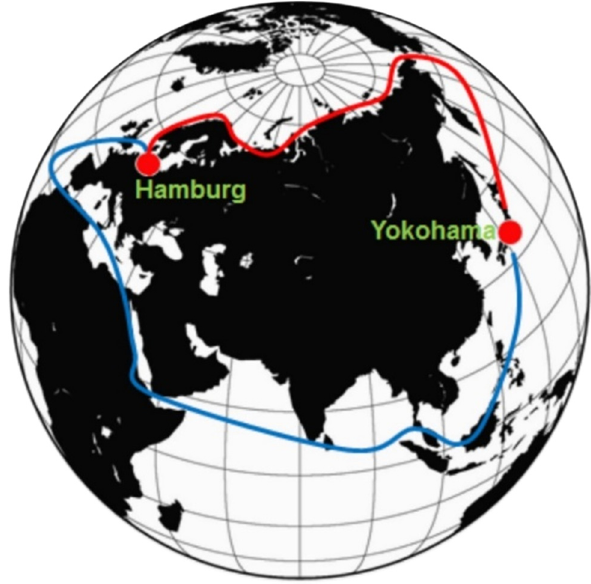
Figure 2: Comparison of shipping between NSR and SCR routes Hamburg to Yokohama [ 28 ] .